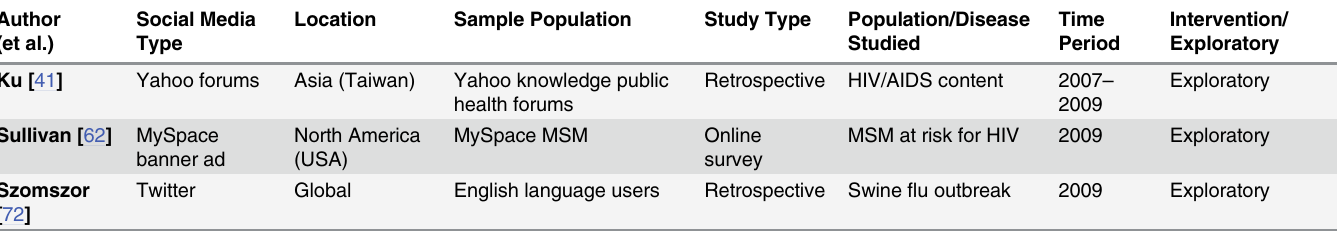
Table 9. Characteristics of 3 infectious diseases studies addressing research question 2 a